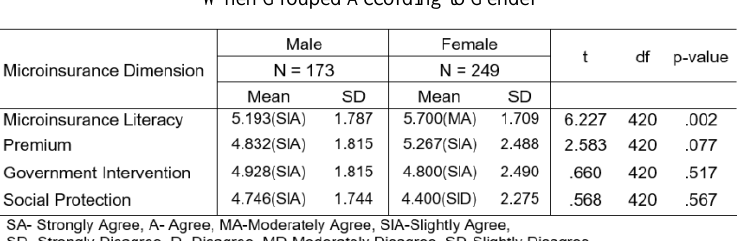
Table 7: Level of Agreement of the Respondents on the Dimensions of Microinsurance When Grouped According to Gender